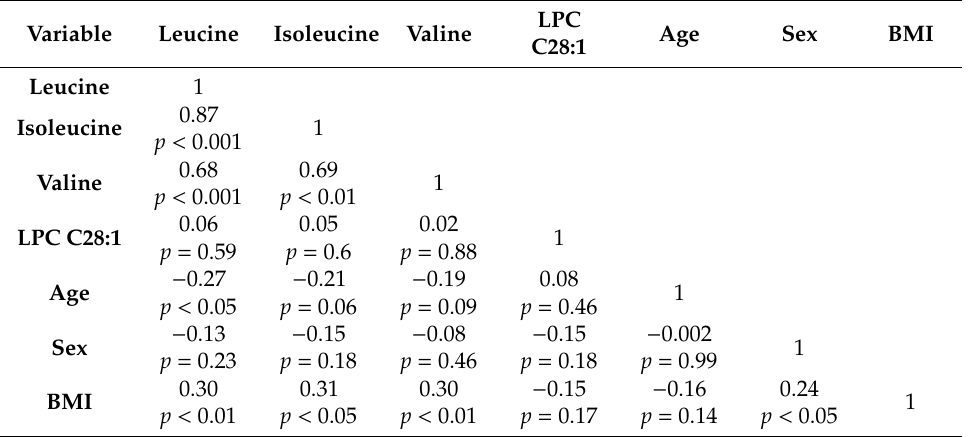
Table 4. Pearson’s correlation matrix for branched-chain amino acids (BCAAs), lysophosphatidylcholine (LPC) acyl C28:1, sex, and baseline age and body mass index (BMI).